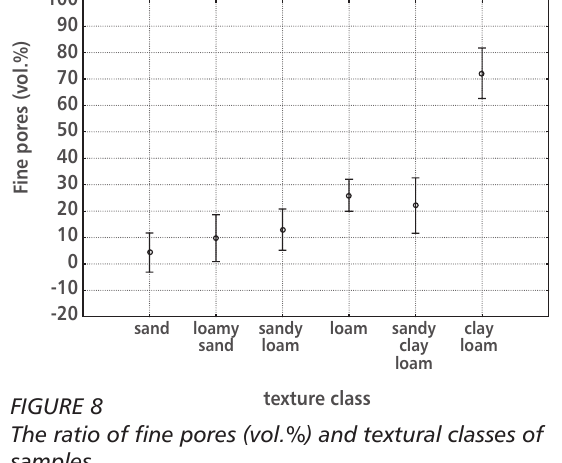
FIGURE 8 The ratio of fine pores (vol.%) and textural classes of